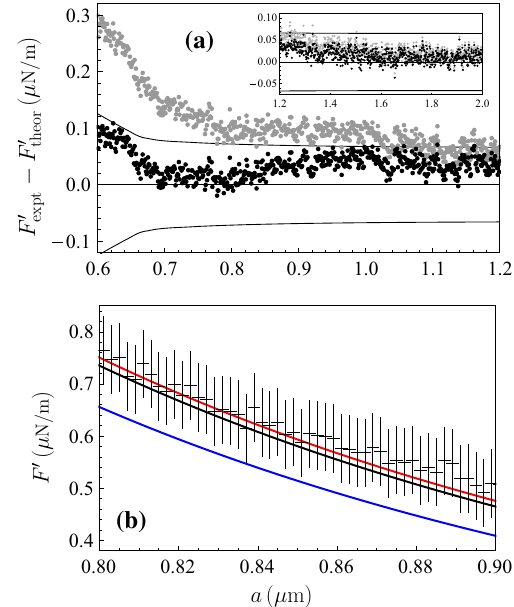
Fig. 3 a The differences between experimental [21] and theoretical gradients of the Casimir force computed using the alternative nonlocal (black dots) and the standard Drude (grey dots) responses are shown as functions of separation. The two solid lines indicate borders of the 67% confidence band (the region of larger separations is shown in the inset). b The experimental [21] gradients shown as crosses are compared with the theoretical ones computed using the standard Drude, the alternative nonlocal, and the plasma response functions are shown by the bottom, middle, and top lines,